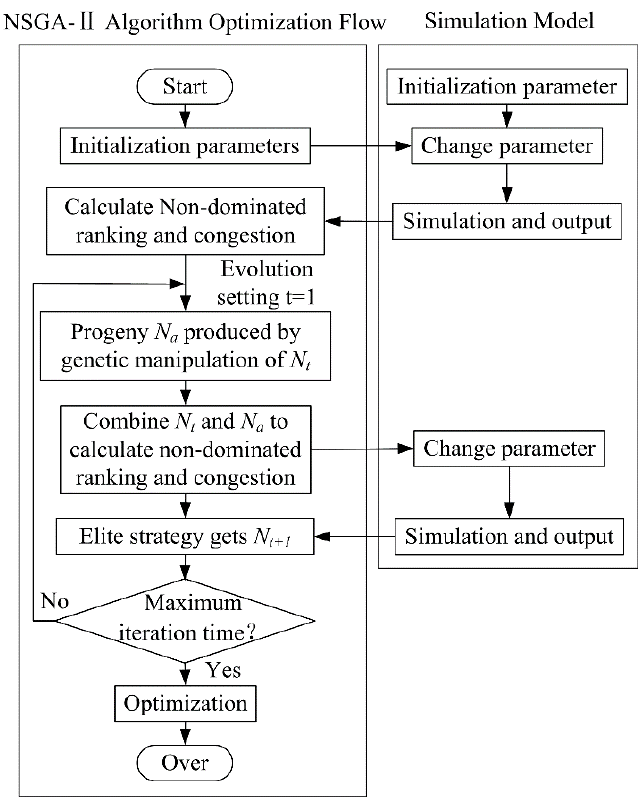
Figure 7. The optimization algorithm processes based on the non-dominated sorting genetic algorithm (NSGA-II).